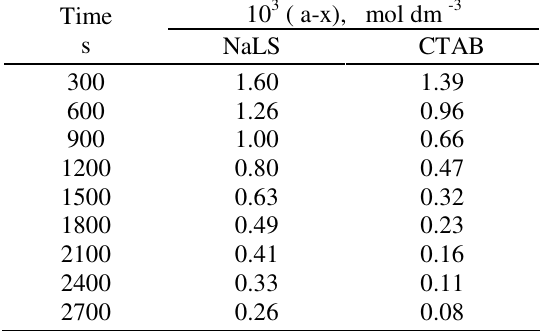
Table 3. First order values for H [(NH ) Co III – L] 2+ = 2.00 x 10 -2 mol dm -3 , [H 3 5 [H SO ]=1.00 mol dm -3 , [ Na LS ]=[CTAB]=2.00 x 10 -3 mol dm -3 , 2 4 Temperature = 35±0.2 0 C, L = mandelato.